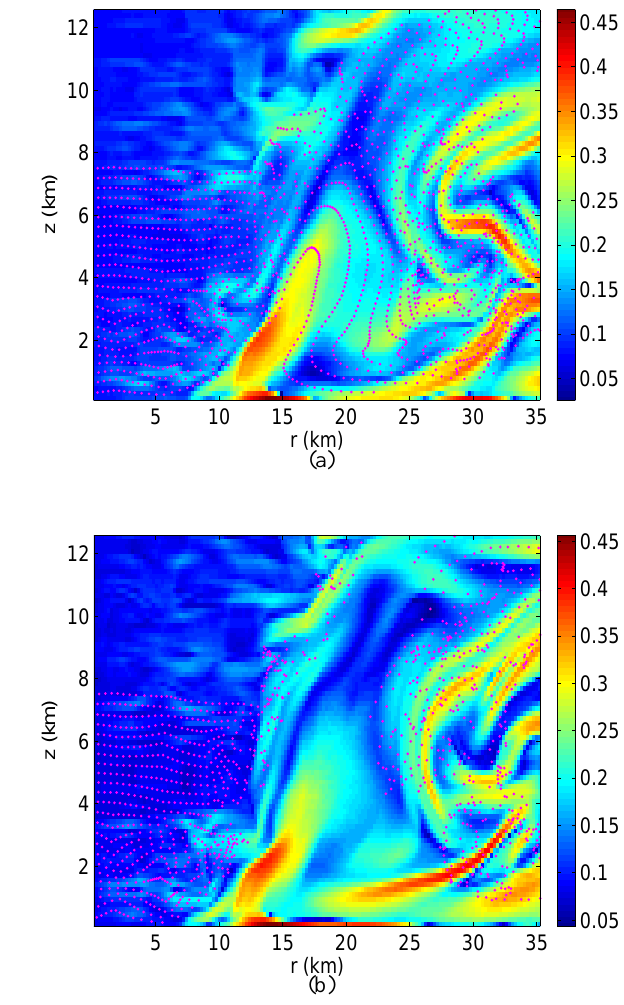
Fig. 7. Backward time FTLE field integrated T = − 20 min. for initial times of 420 minutes (a) and 460 minutes (b). The red dots mark the positions at time t = t 0 of trajectories seeded on a uniform grid at 400 min.